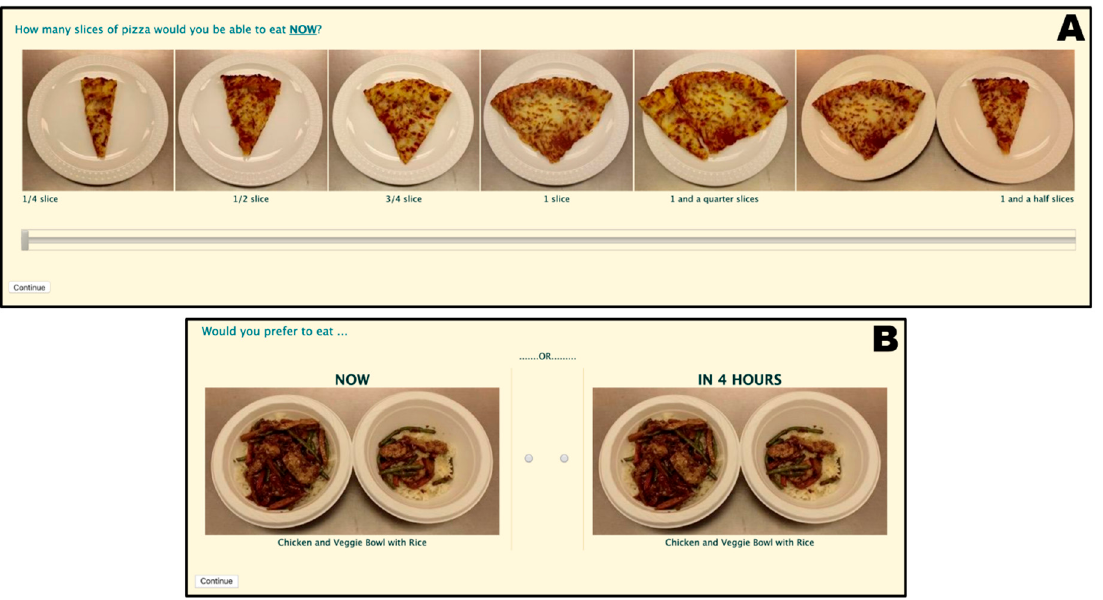
Figure 1. Examples of questions employed for the quantification of food amount preferences ( A ) and intertemporal food preferences ( B ).